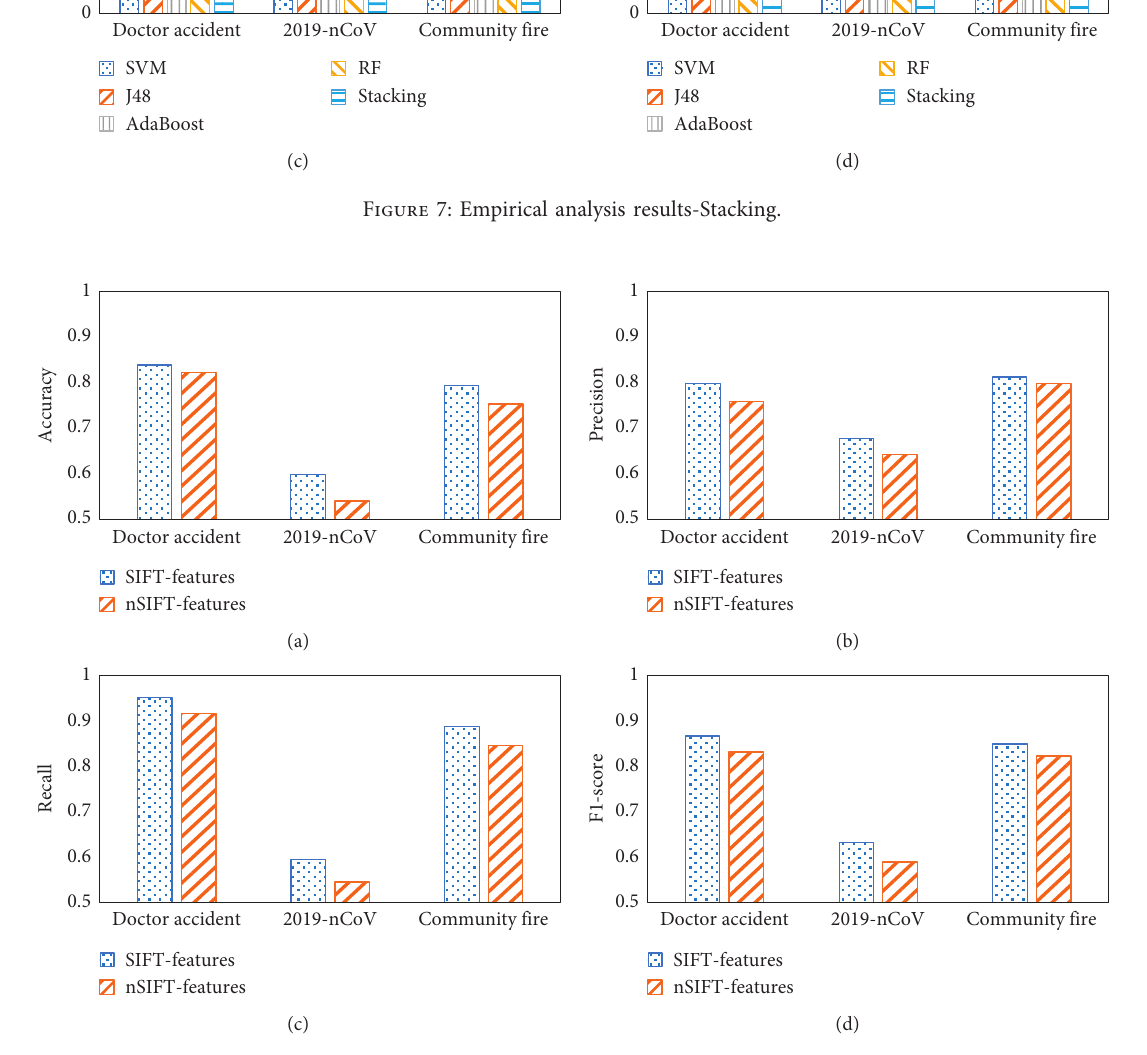
Figure 8: Empirical analysis results-feature